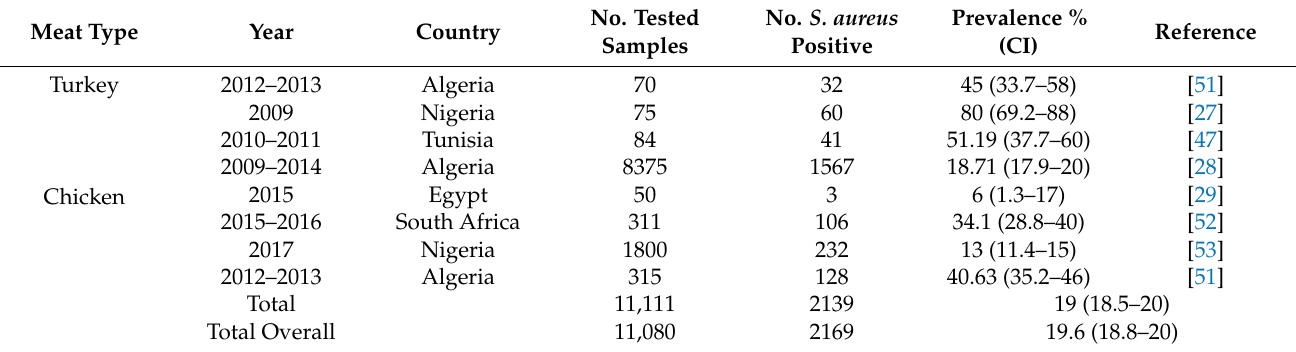
Table 2. Prevalence of S. aureus in raw unprocessed poultry in African countries.